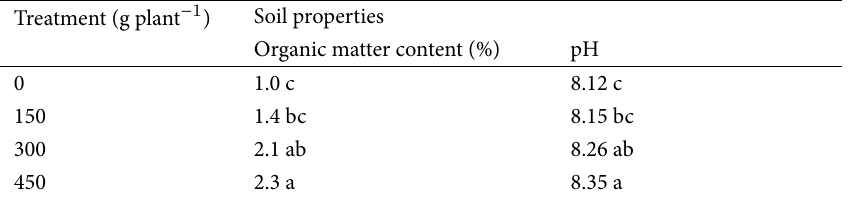
Table 9 The effects of biochar levels on organic matter content and soil pH.